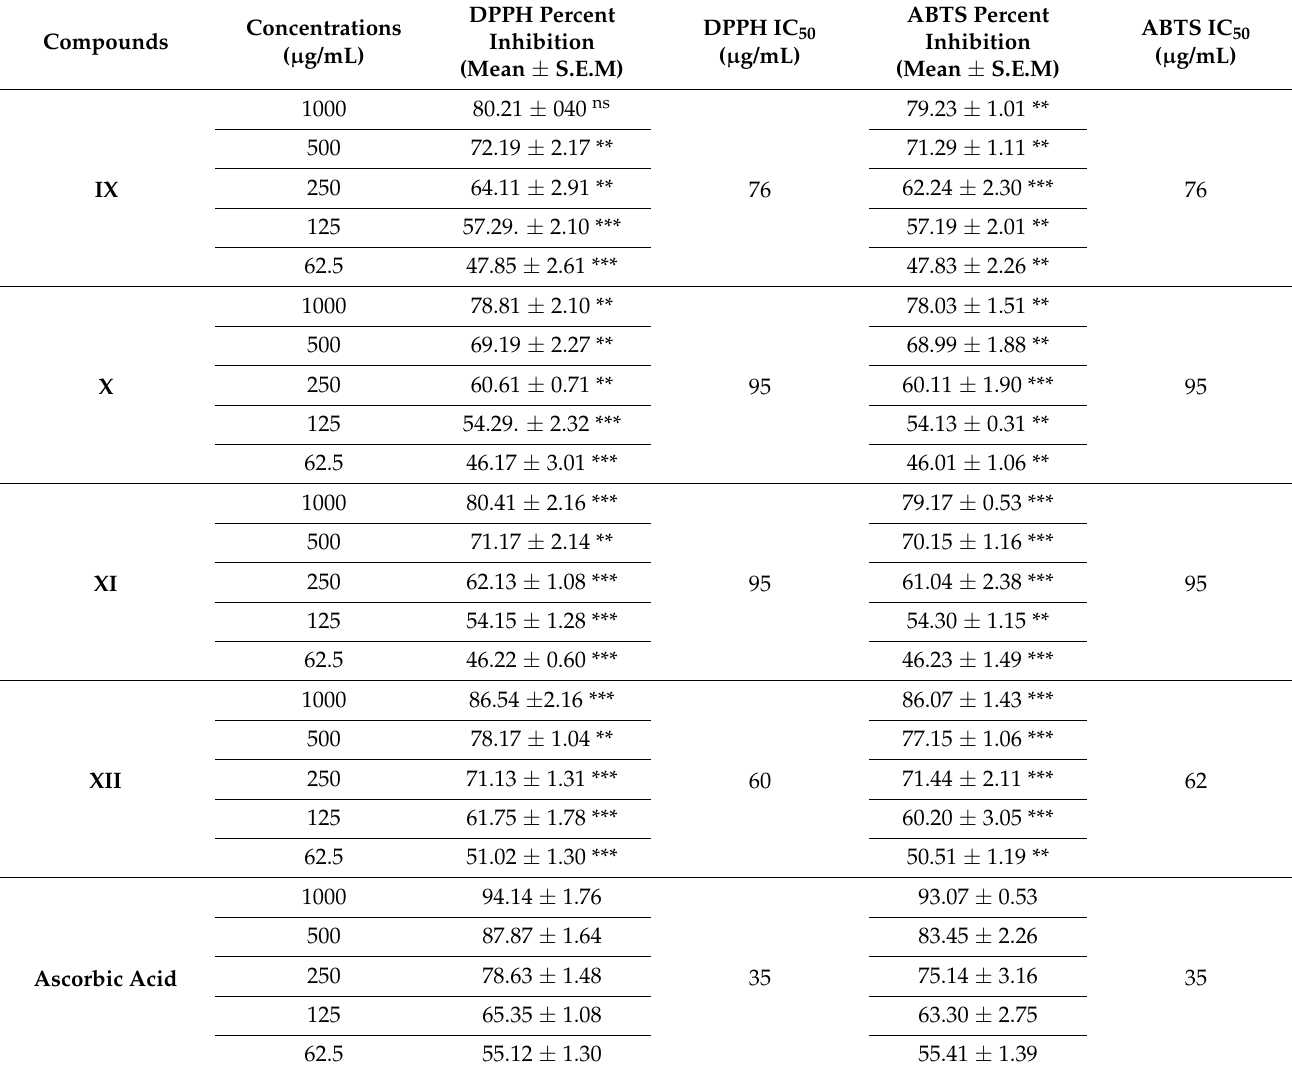
Table 1. Percent 2,2-diphenyl-1-picrylhydrazyl (DPPH) and 2,2’-Azino-bis(3-ethylbenzthiazoline-6-sulfonic acid) (ABTS) radical scavenging potential of